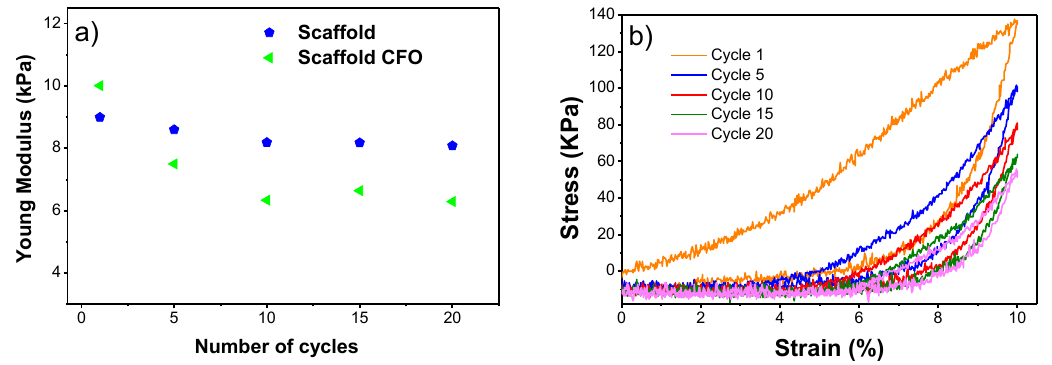
Figure 7. ( a ) Young’s modulus of the PHBV scaffolds with and without CFO along the compression cycles and ( b ) characteristic stress–strain curves of the PHBV scaffolds with CFO for compression assays at 10%.